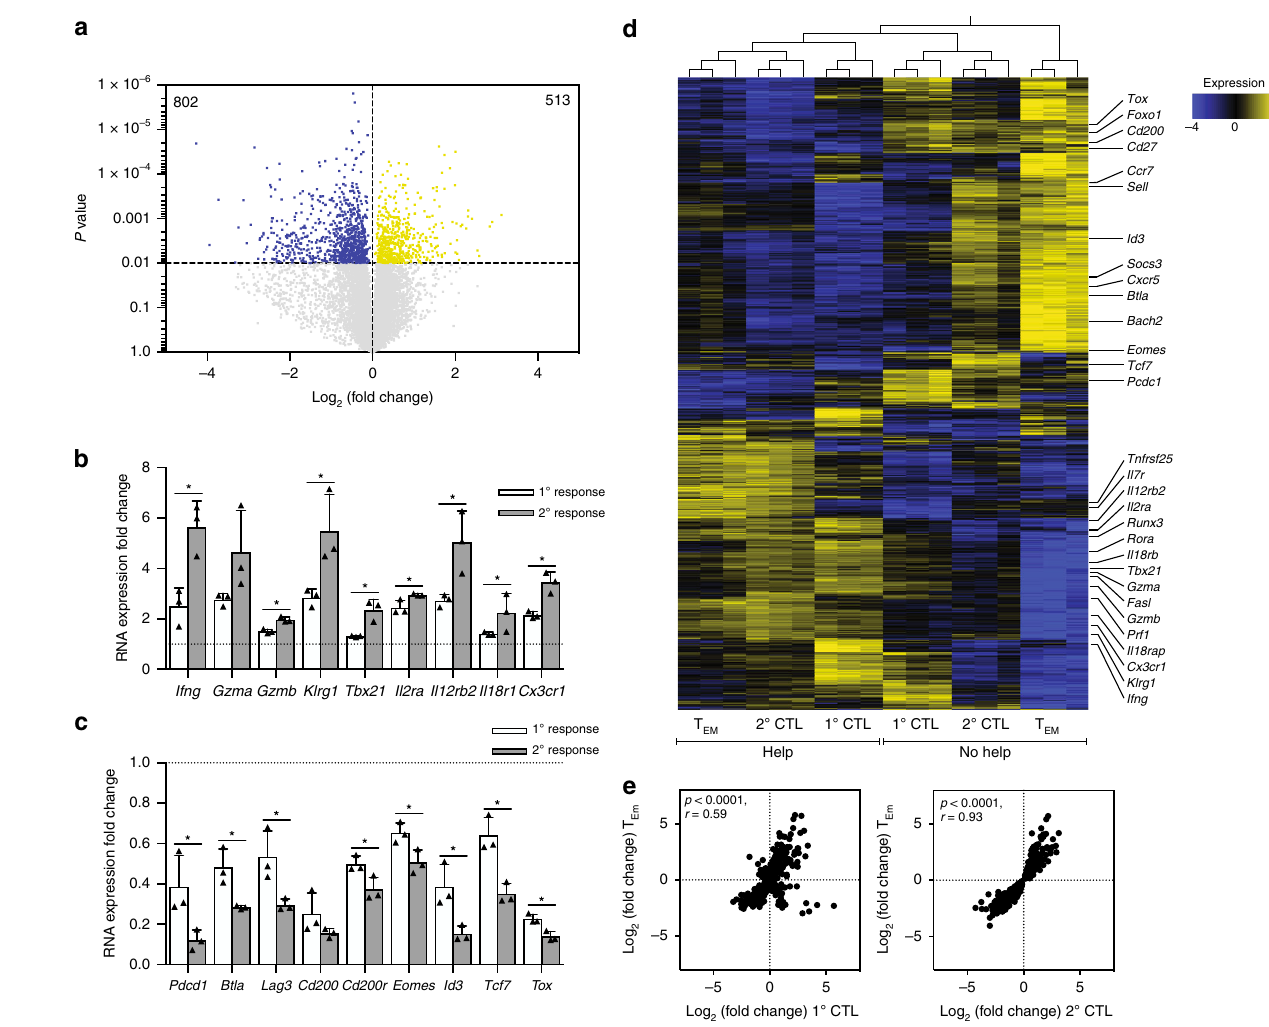
Fig. 5 Helped memory CD8 + T cells express the Help signature genes after recall with MHC class I-restricted peptide only. Mice received primary vaccination with Help or No Help vaccine and were recalled at day 50 with No Help vaccine + LPS, as outlined in Fig. 1a. At day 10 of the secondary response, E7-speci fi c CD8 + T cells were fl ow cytometrically isolated form the spleen ( n = 3) and samples were processed for RNAseq. a Volcano plot depicting results of comparative transcriptome analysis of helped versus helpless secondary effectors. Blue and yellow dots indicate transcripts with signi fi cant differential expression between the two groups ( p < 0.01) See also Supplementary Data 3. b , c Fold change in mRNA expression of a number of signature genes differentially expressed in the Help versus No Help setting of the primary response (1 o ), as determined before 20 or the secondary response (2 o ), as determined here. d Hierarchical clustering of genes that were differentially expressed in the Help versus No Help groups in steady-state T EM (Fig. 3), primary (1 o ) CTLs 20 or secondary (2 o ) CTLs ( a ). Certain genes of known or suspected functional or diagnostic relevance are annotated. e Correlation between log 2 fold changes in mRNA expression of genes differentially expressed in helped versus helpless T EM cells and primary (1 o ) CTLs (left panel) or secondary (2 o ) CTLs (right panel). Error bars indicate SD, * p < 0.05 (unpaired two-tailed Student ’ s t test). Source data are provided as